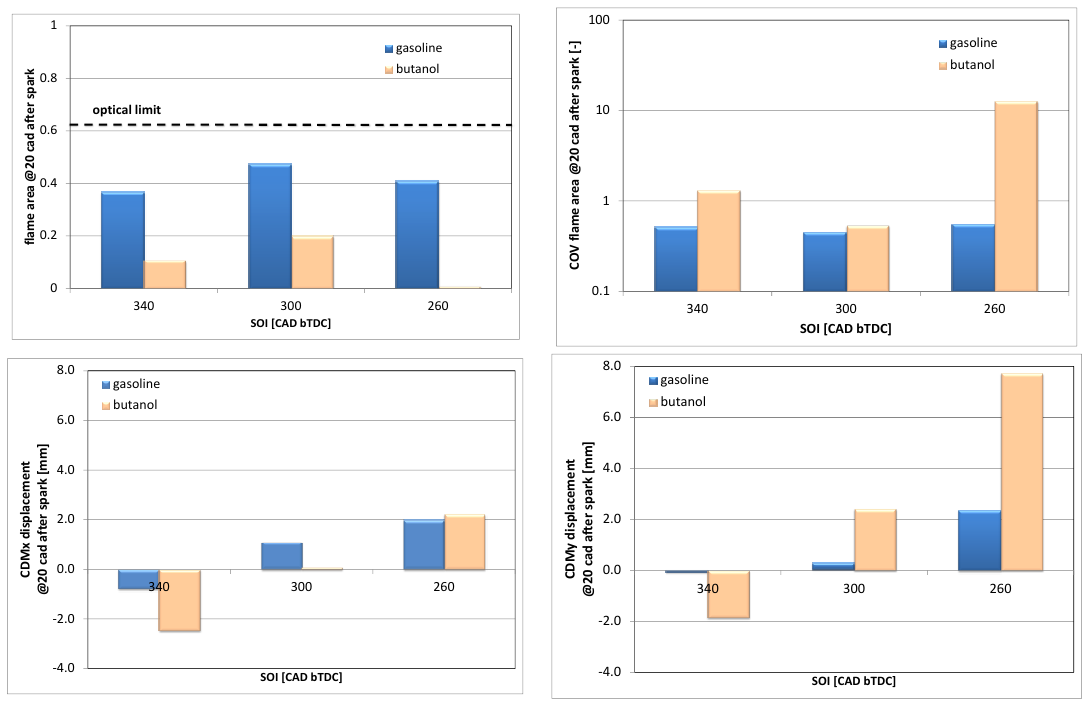
Figure 10. Flame area, variability and displacement averaged over 20 consecutive